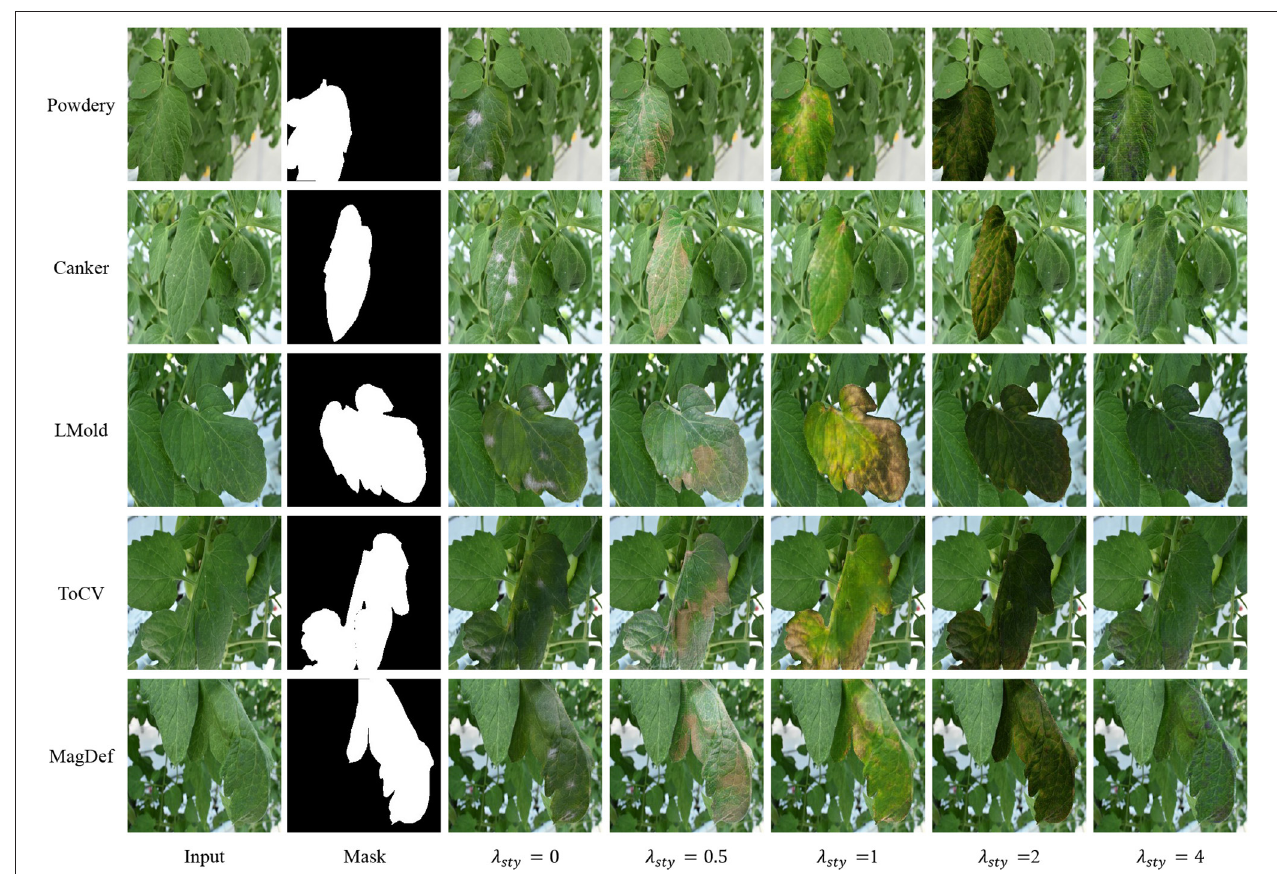
FIGURE 8 | Some generated samples to do data augmentation for object detection and instance segmentation in which one image could include more than one leaves but we can just translate the desired one and maintain the others.